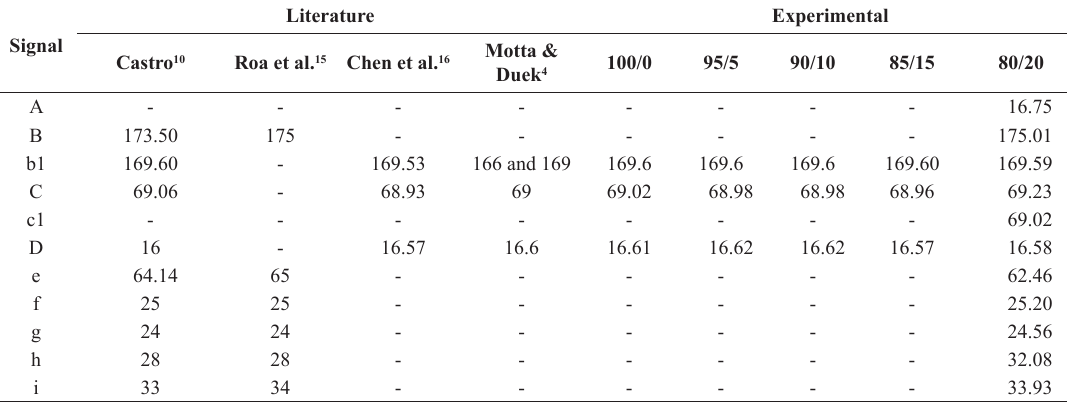
Table 2. Chemical shifts (ppm) from 13 C-NMR spectra cited in literature and obtained experimentally Literature Signal Castro